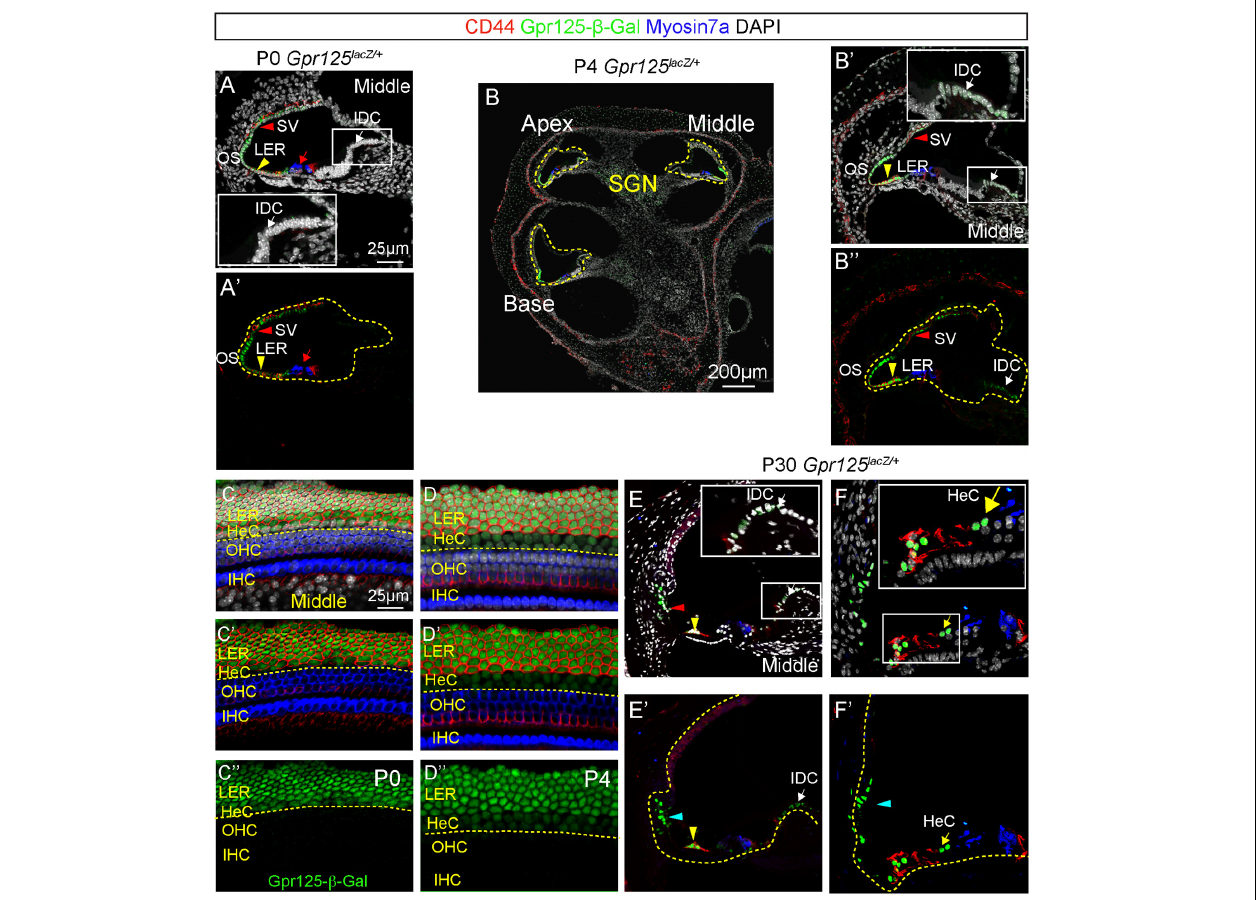
FIGURE 3 | Expression of Gpr125 in the postnatal cochlea. (A,A’) Representative image of section of the middle turn of P0 Gpr125 lacZ / + cochlea. Gpr125- β -Gal was detected in the lateral cochlear wall, stria vascularis (SV, red arrowheads), outer sulcus, SGNs, and LER (yellow arrowheads). CD44 marks Claudius cells. Inset demonstrates high magnification of interdental cells (IDC, white arrows) in panel (A) . No expression was detected in the IDCs or outer hair cells (red arrows). (B) Midmodiolar sections of P4 Gpr125 lacZ / + cochlea showing Gpr125- β -Gal expression in the LER, SGNs, SV, and outer sulcus. (B’,B”) At P4, Gpr125- β -Gal expression was detected at the lateral cochlear wall, SV (red arrowheads), outer sulcus, IDCs (white arrows), and LER (yellow arrowheads). (C–D”) Whole mount preparation of P0 and P4 Gpr125 lacZ / + cochleae showing β -Gal and CD44 expression in LER, and Gpr125- β -Gal expression alone in Hensen’s cells (HeC). (E–F’) At P30, Gpr125- β -Gal expression was detected in Claudius cells (yellow arrowheads), Hensen’s cells (yellow arrows), and outer sulcus (cyan arrowheads). Relative to P4, Gpr125- β -Gal expression in the IDC (white arrows) is more intense. Insets show magnification of boxed areas in A–E. SV, stria vascularis; LER, lesser epithelial ridge; OHC, outer hair cells; SGN, spiral ganglion neurons; IHC, inner hair cells.